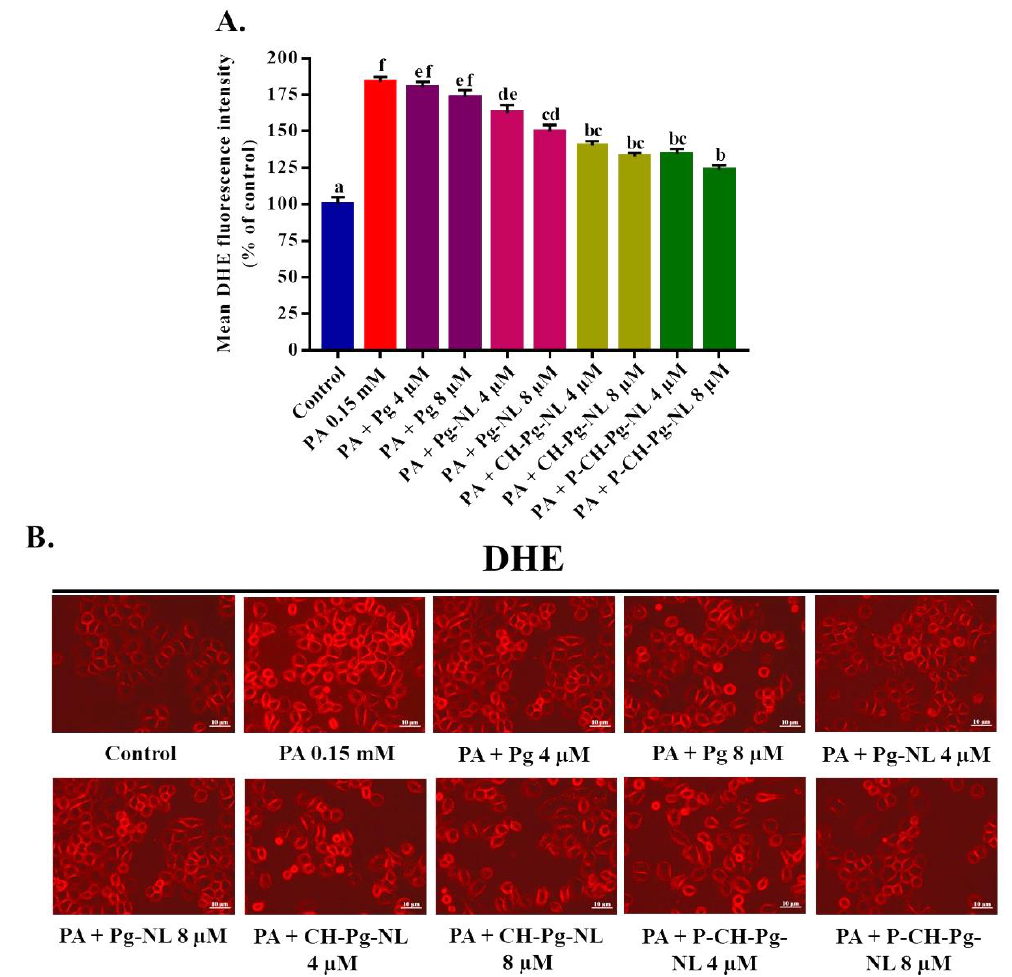
Figure 5. Effects of free-Pg and Pg-loaded liposomal systems on PA-induced intracellular